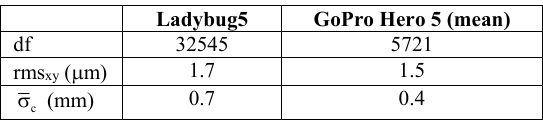
Table 1. Case 2 adjustment data